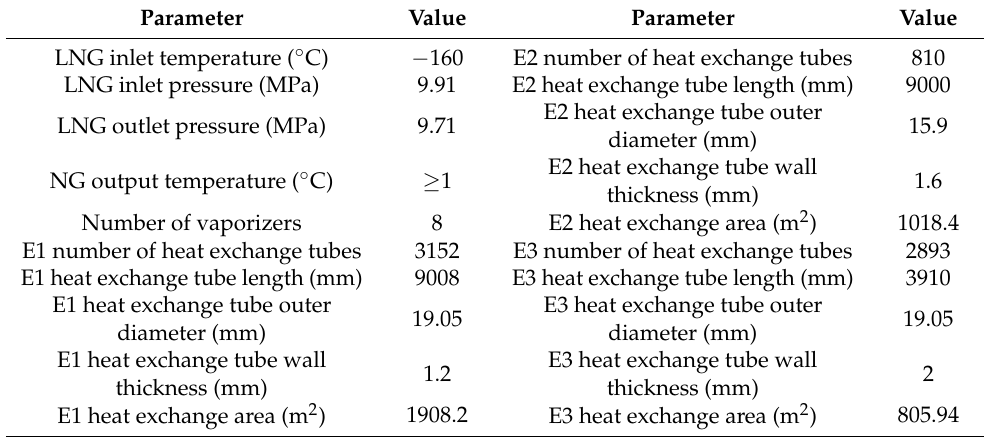
Figure 1. Schematic diagram of the IFV structure. Table 1. Key parameters of the IFV.